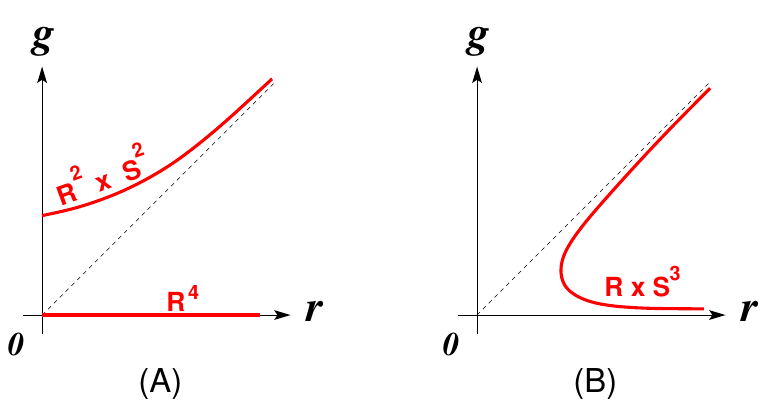
Figure 17 . Two geometric phases of the coassociative 4-manifold (5.1){(5.2) in R 3 (cid:2) Taub-NUT. To illustrate only the homotopy type, we replace Taub-NUT by R 4 and Spin bundle over C P 1 (cid:24) = S 2 by R 2 (cid:2) S 2